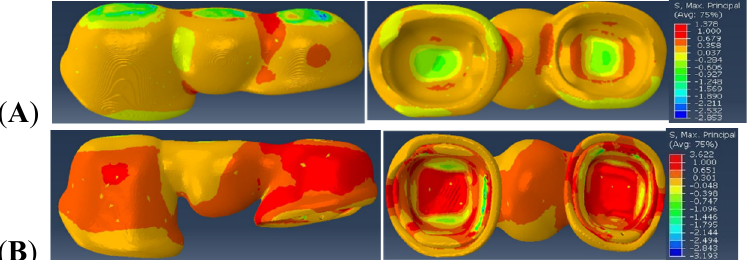
Figure 4. Stress distribution in the ( A ) Veneer and ( B ) Framework region of Model B.